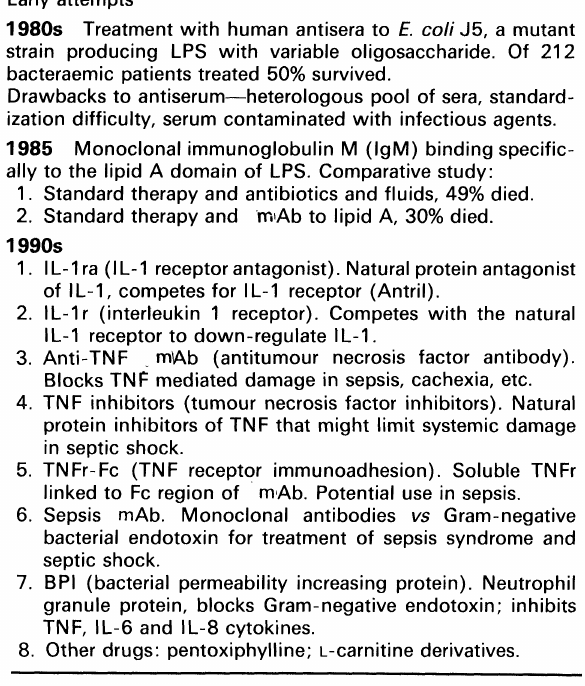
Table 16. Tumour necrosis factor leading to septic shock The most prominent bacterial infections are E. coli, P. aeruginosa, Klebsiella and Bacteroides. When these are present in blood (bacterial sepsis), levels of TNF increase, and autocrine and paracrine effects increase L-1 and L-6. The combined effect Leads to depressed myocardial contractility (reduces tissue